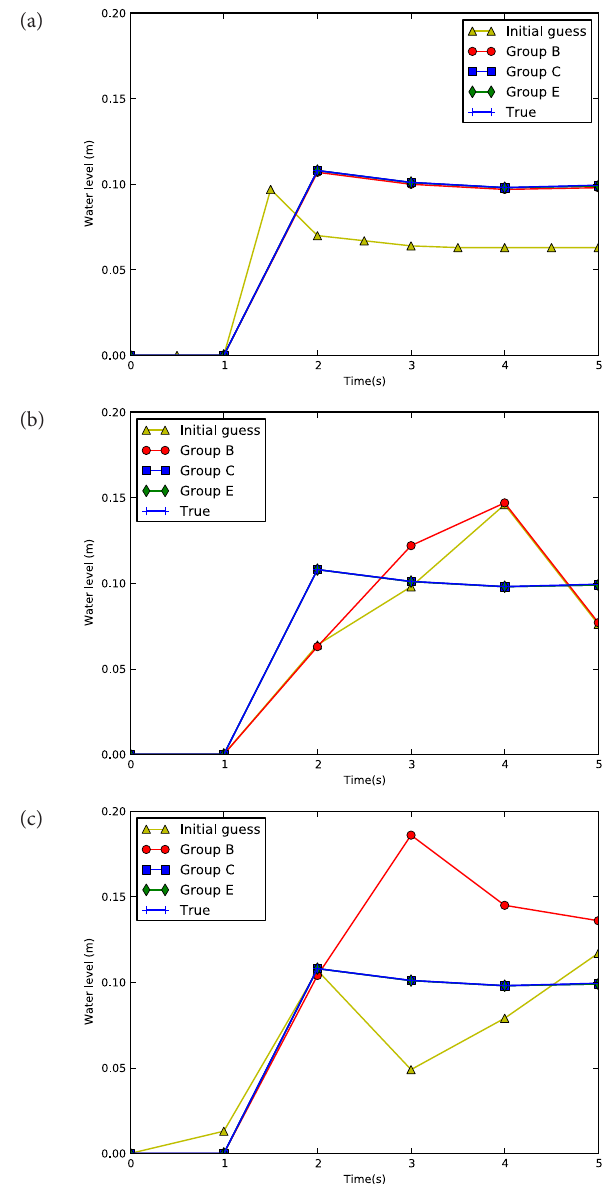
Figure 5. Water stage validation at the gauge point in (a) experiment series A, (b) experiment series B, and (c) experiment series